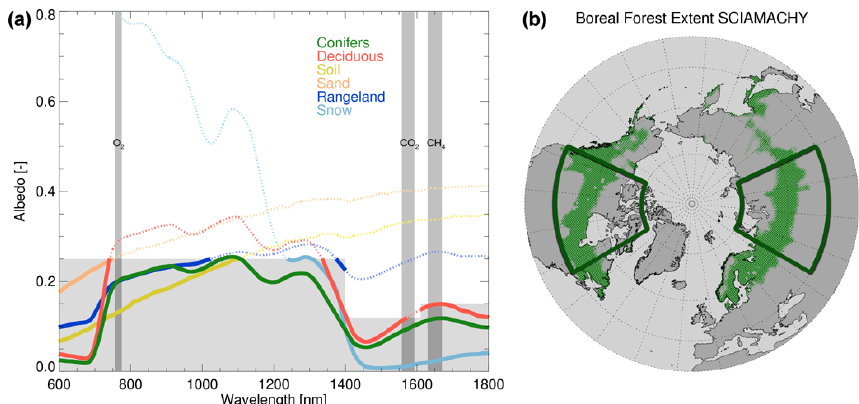
Fig. 6. Selection of the regions for the boreal forest carbon dioxide uptake analysis. The global conifer distribution can be extracted using specific thresholds on the retrieved albedos in the three WFM-DOAS fitting windows (O 2 , CO 2 , and CH 4 ). The fitting windows, used thresholds, and spectral albedos of typical natural land surface types (reproduced from the ASTER Spectral Library through the courtesy of the Jet Propulsion Laboratory, California Institute of Technology, Pasadena, California ( © 1999, California Institute of Technology) and the Digital Spectral Library 06 of the US Geological Survey) are shown in (a) demonstrating that only conifers pass the three window spectral albedo threshold filter. The deduced boreal forest extent is illustrated in (b) . The highlighted region is used for the following analysis because it covers the bulk of the boreal forest area of the planet and the individual parts are equally sized and span the same latitude range ensuring similar solar zenith angles for the corresponding SCIAMACHY